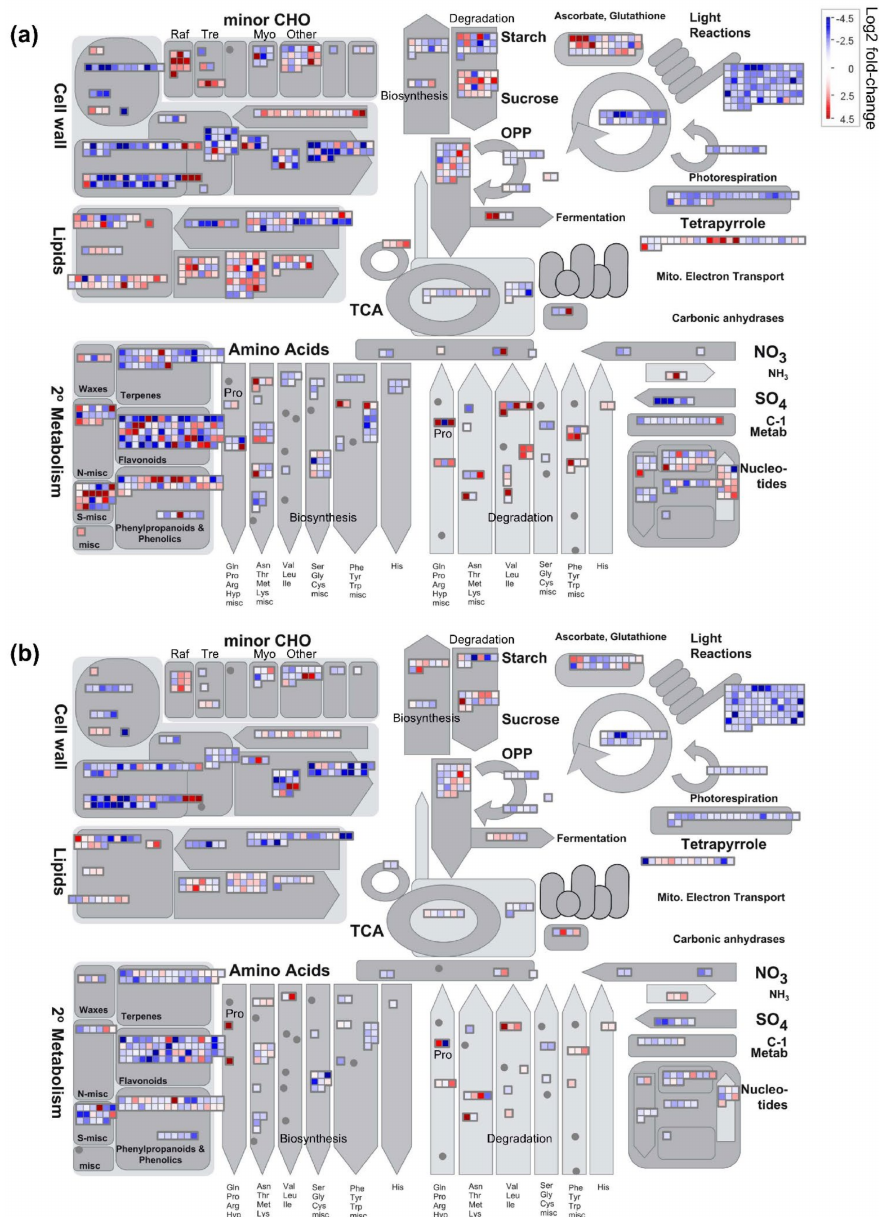
Figure 4. Transcriptional alterations in general metabolic pathways in ‘sativa’ ( a ) and ‘falcata’ ( b ) plants under control vs. drought conditions. Pathway analysis was conducted using MapMan, with blue boxes indicating down-regulated genes and red boxes denoting up-regulated genes. Myo, myo- inositol metabolism; Pro, proline metabolism; Raf, raffinose metabolism; Tre, trehalose